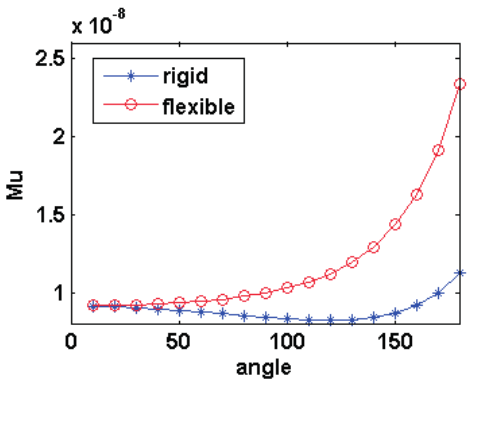
Figure 11. Comparison of simulation results.